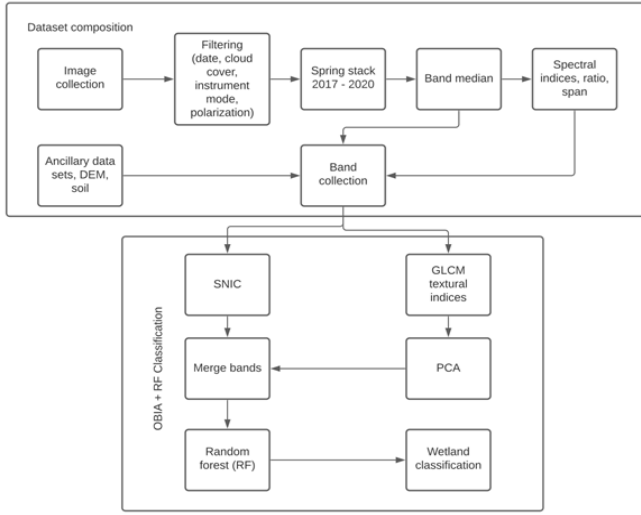
Figure 4. Flowchart of the methodology used for wetland